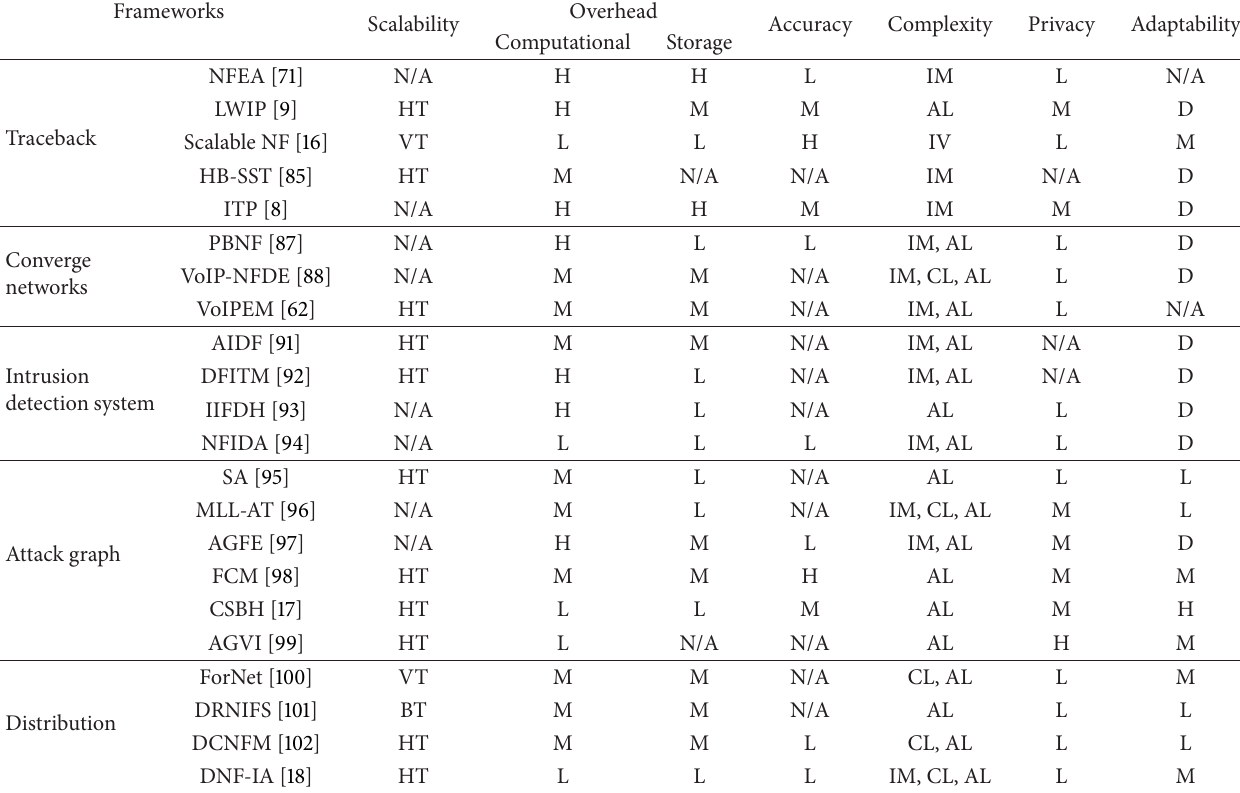
Table 6: Analysis of network forensics frameworks in context of adaptability to